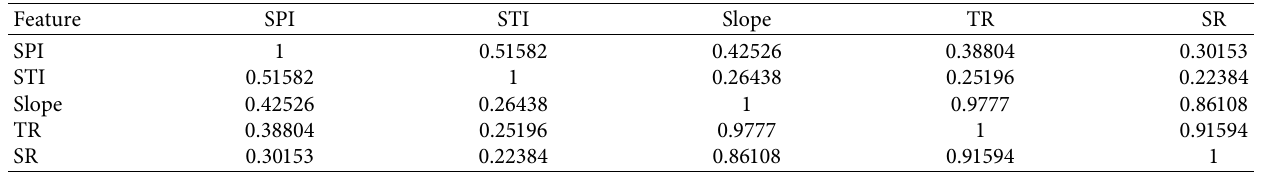
Table 5: The correlation coefficient of terrain factors.